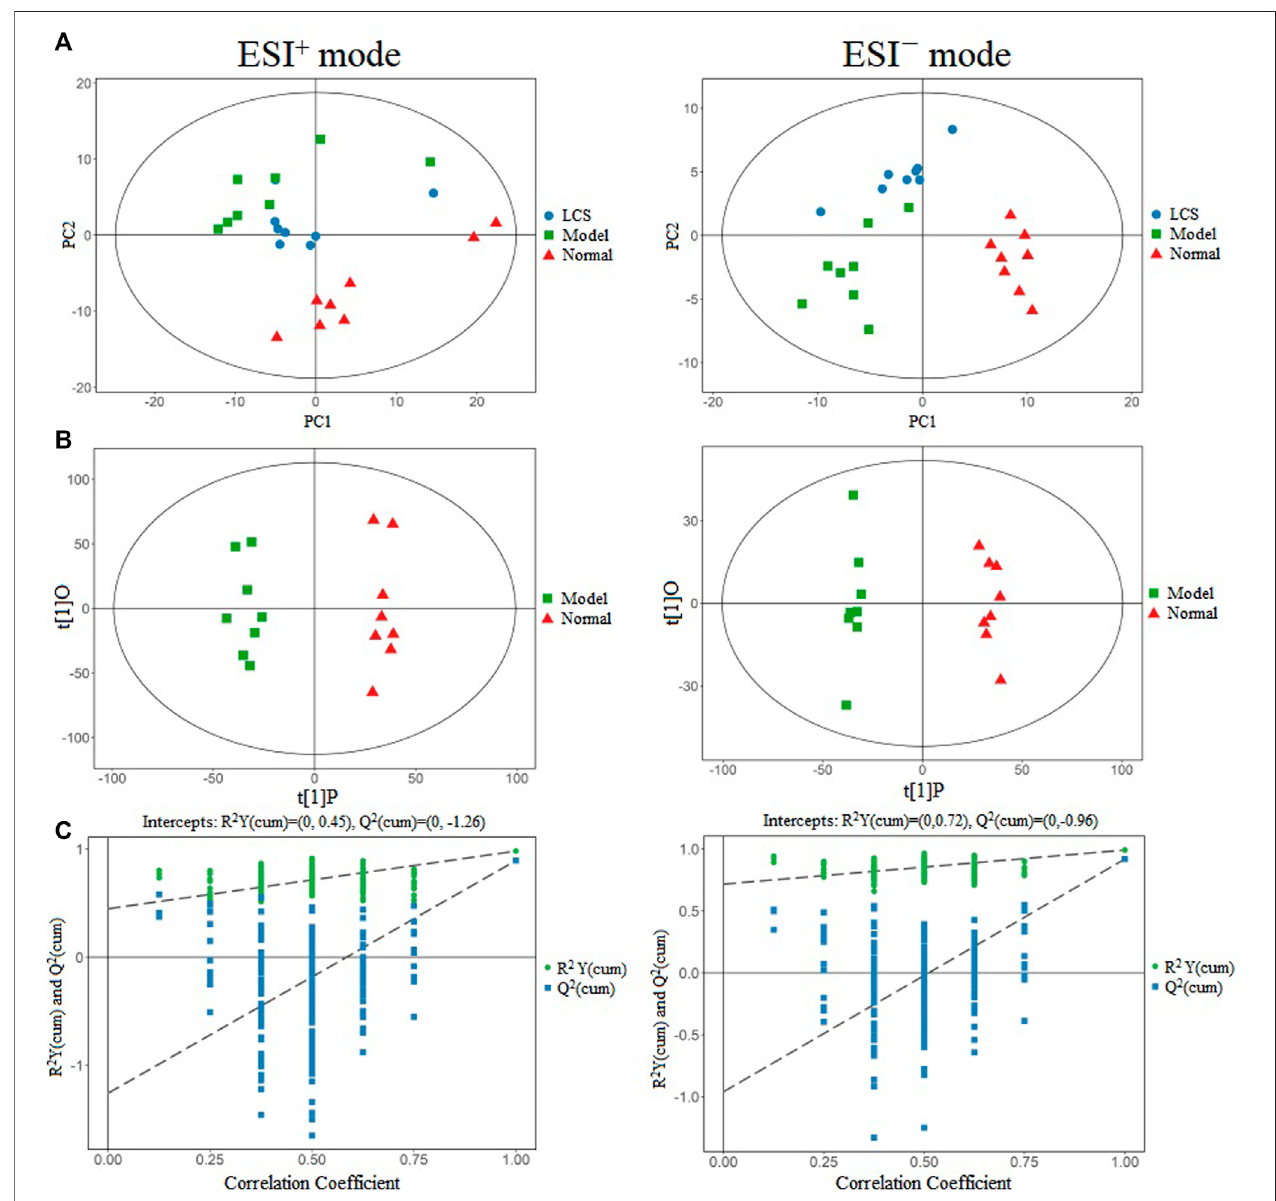
FIGURE 7 | Multivariate data analysis of metabonomics for liver injury treatment of LCS. Note: (A) PCA score plots in positive ion mode and negative ion mode for the LCS, normal and model groups. (B) OPLS-DA score plots in positive ion mode and negative ion mode for the normal and model groups. (C) The 200-permutation test of OPLS-DA model for the normal and model